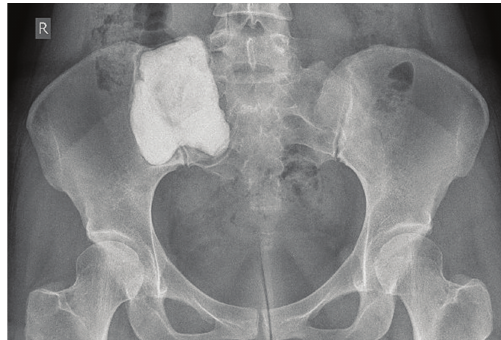
Figure 2: X-ray after curettage and bone cement packing of a sacral tumor. Postoperative X-ray of case 14 after intralesional curettage and bone cement